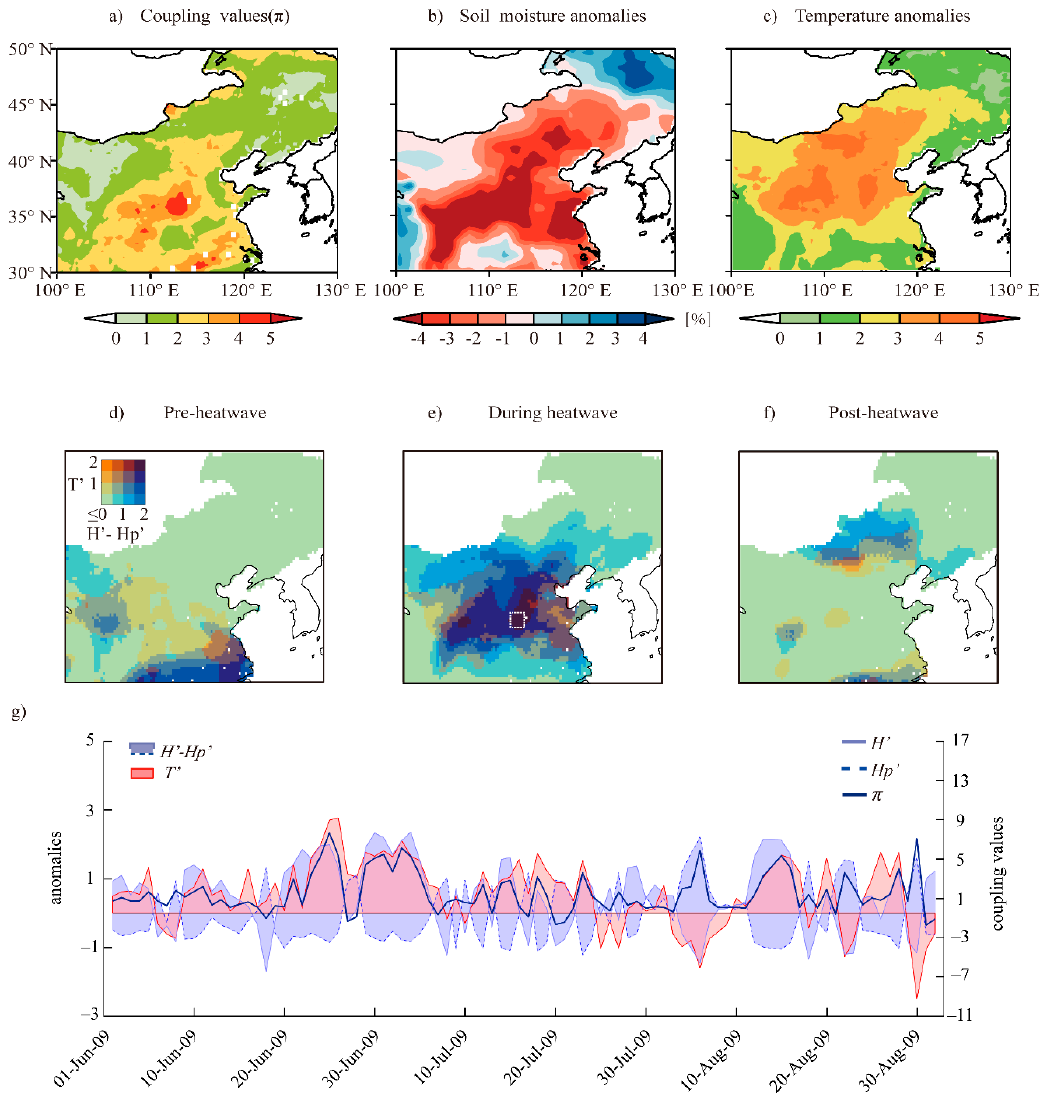
Figure 6. The soil moisture–temperature coupling and related processes during the summer heatwave of North China during 20 June–4 July 2009. ( a ) The coupling metric π ; ( b ) the soil moisture anomalies and ( c ) the temperature anomalies referring to the multi-year average of 1980–2013; ( d ) pre-heatwave (12–19 June); ( e ) the occurrence of the heatwave (20 June–5 July); ( f ) the days after the heatwave (6– 13 July); ( g ) daily time series of 𝑇 (cid:4593) , 𝐻 (cid:4593) , 𝐻 (cid:3043)(cid:4593) , and the coupling metric π .